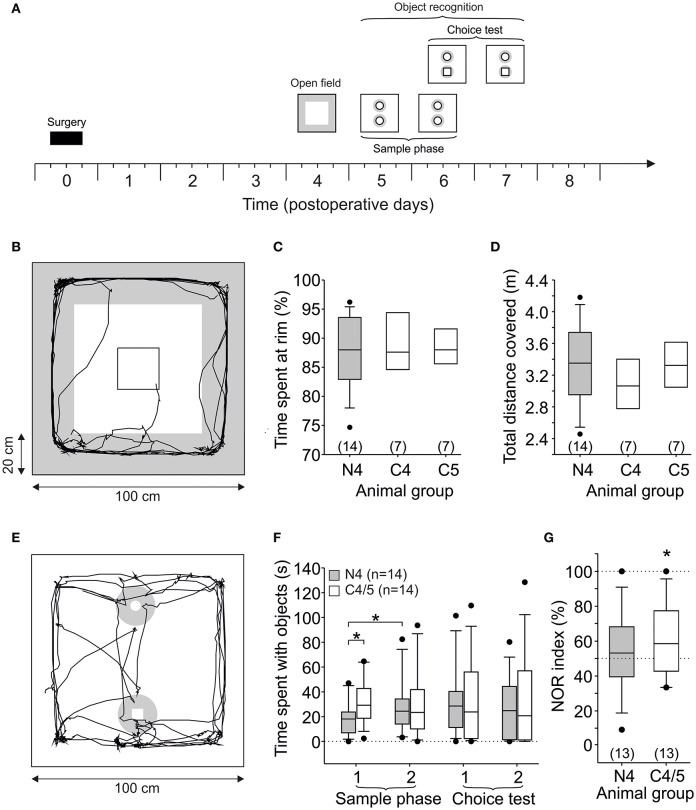
Open field and novel object recognition. (A) Time frame of the behavioral experiment. The open field test was performed on post-operative day 4 or 5 (here only shown for animals which started on post-op day 4). Object recognition was tested on three consecutive days. Note that sample phase 2 and choice test 1 are on the same day with a delay of 1.5–3 h. (B) Scheme of the arena (100 × 100 cm) with trajectory of a control animal (group C5) inserted within the center which stays at the 20 cm rim for almost the complete period. (C) Time spent at the rim (20 cm) of the arena was not different between all three groups. (D) Total distance covered during 5 min was also not different between all three groups. (E) Scheme of the arena equipped with two objects, and exploration was defined as presence of the animal close to the object (diameter 18 cm, gray zone). (F) Time spent with the objects in NMDAR-CSF-treated and control rats during the behavioral experiment. (G) NOR index for choice test 1. Note that random presence of the animal at the objects would lead to a NOR index of 50%. The asterisk indicates a significant difference of the observed values against this chance level of 50%. Two animals (one NMDAR-CSF-treated and one control rat) spent no time at both objects during the choice test, these animals were not included for the NOR index calculation (i.e., n = 13 instead of 14). (*P < 0.05).